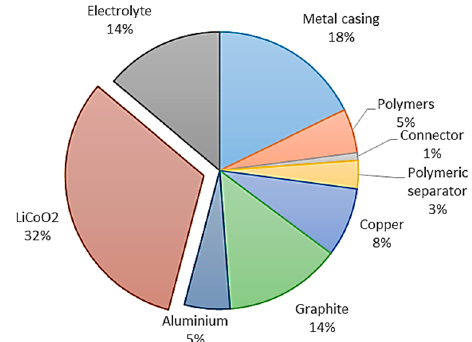
Figure 2. Bill of materials of lithium-cobalt oxide battery (wt.%) (based on data provided by Silveira et al. [27]).